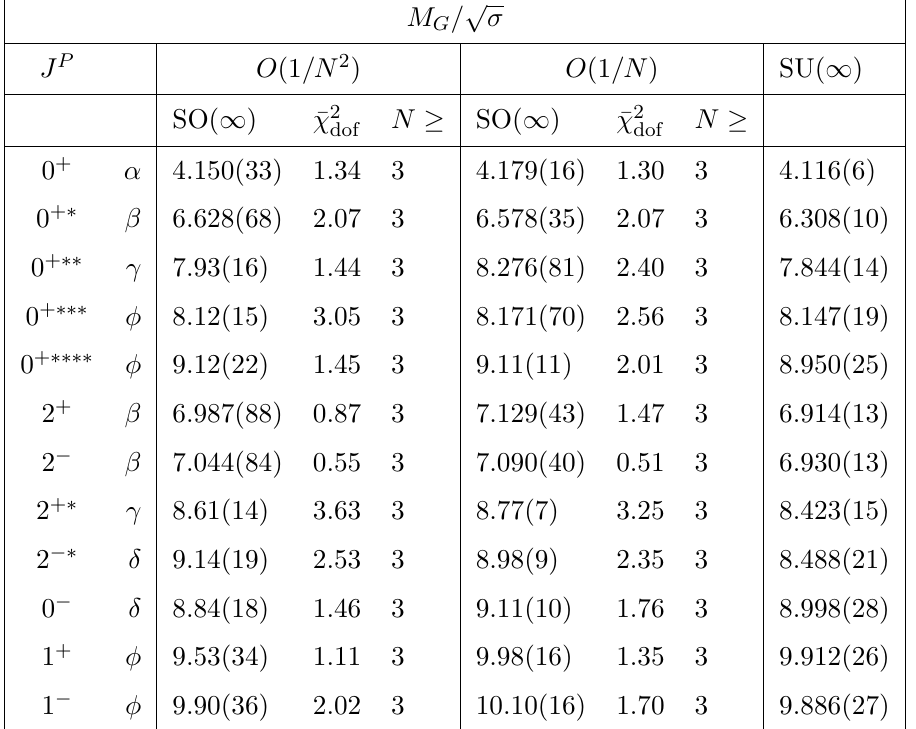
Table 31 . Continuum glueball masses in units of the string tension extrapolated to N = 1 , with the (cid:31) 2 per degree of freedom and range in N : for the best linear and quadratic (cid:12)ts in 1 =N . Also the values for SU( 1 ) from [16]. Grades, e.g. (cid:11) , explained in section